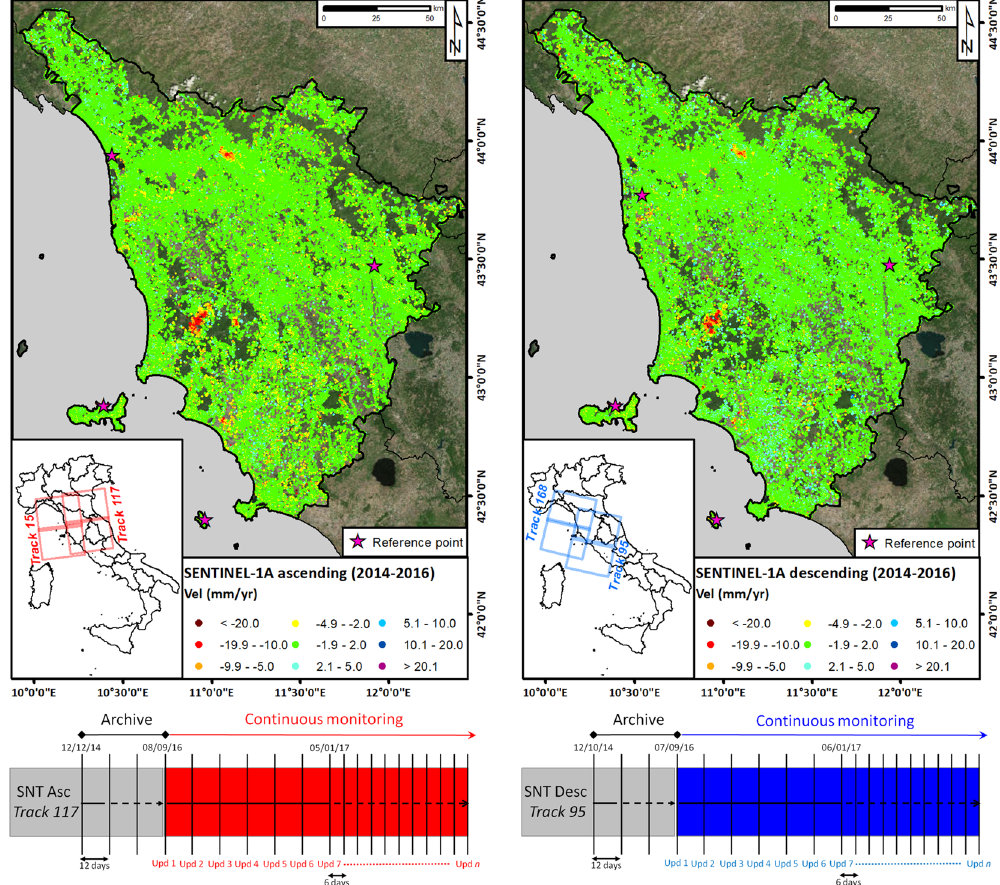
Figure 1. Ground deformation maps (displacement rates) for the Tuscany Region obtained from SqueeSAR data. Sentinel-1 acquisition plans for continuous monitoring are also shown. Deformation rates ranging between − 2.0 and 2.0 mm/yr, indicate relatively stable ground conditions. Positive values correspond to motion toward the satellite; negative values correspond to motion away from the satellite. (Left) Results for the Sentinel-1A archive in ascending geometry. The Sentinel-1 acquisition plans for track 117 (ascending geometry on East Tuscany) is also reported. (Right) Results for the Sentinel-1A archive in descending geometry. The Sentinel-1 acquisition plans for track 95 (descending geometry on East Tuscany) is also reported. Maps were generated using ESRI ArcGIS 10.3 platform